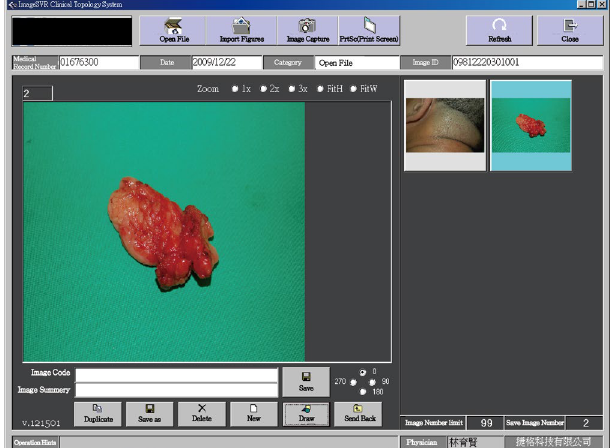
Figure 7. Uploading the photograph of a